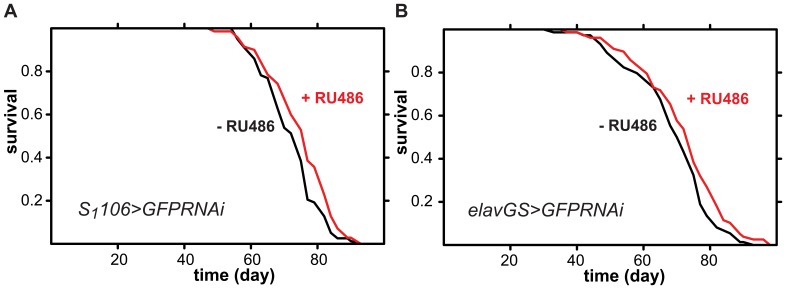
Adult-induced expression of dsRNA targeting GFP for RNAi in midgut and abdominal fat body or in neurons does not shorten lifespan in Drosophila females.Mated female flies of indicated genotype were fed 1 SYA food containing RU486 (red lines) or not (black lines) from day two of adulthood. A Log-rank test detected a slight but significant increase in lifespan in the induced compared to the uninduced condition (p = 0.04, n =  ∼80 per condition). B Log-rank test did not detected significant differences between the induced and uninduced conditions (p>0.05, n =  ∼80 per condition).